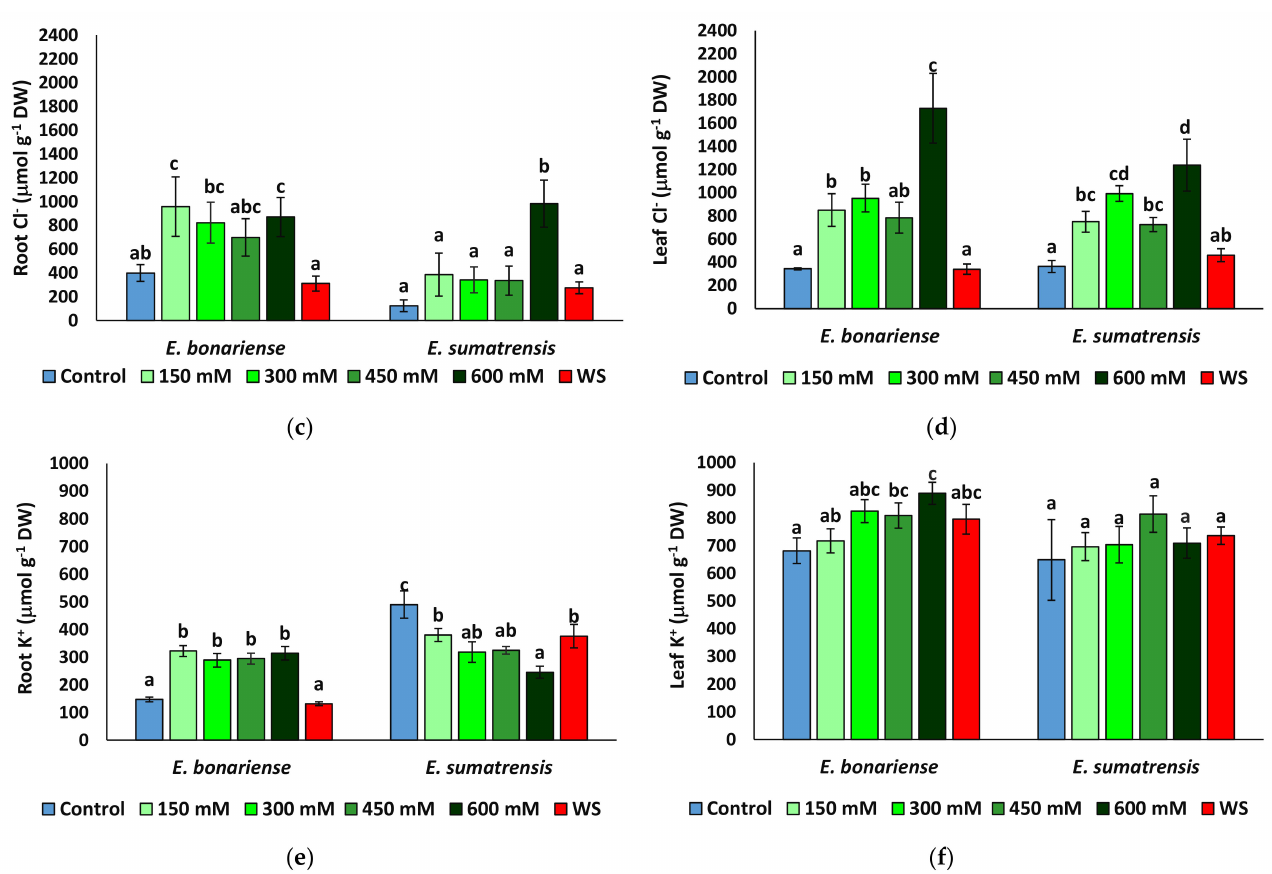
Figure 5. Ion contents in roots and leaves of Erigeron bonariensis and E. sumatrensis plants after 1 month of treatments with the indicated NaCl concentrations or 1 month of water stress (WS) (mean ± SE, n = 7): ( a ) Na + in roots; ( b ) Na + in leaves; ( c ) Cl − in roots; ( d ) Cl − in leaves; ( e ) K + in roots; ( f ) K + in leaves. Same letters indicate homogeneous groups between treatments for each species, according to the Tukey test ( α <